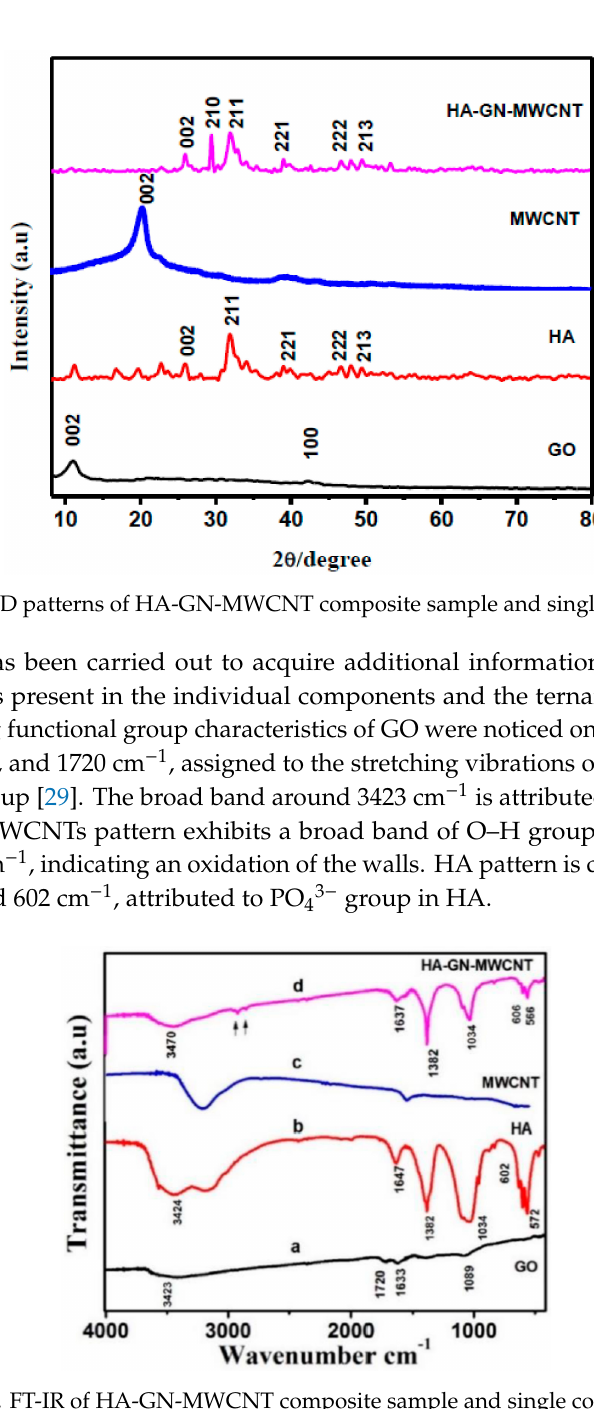
Figure 5. FT-IR of HA-GN-MWCNT composite sample and single